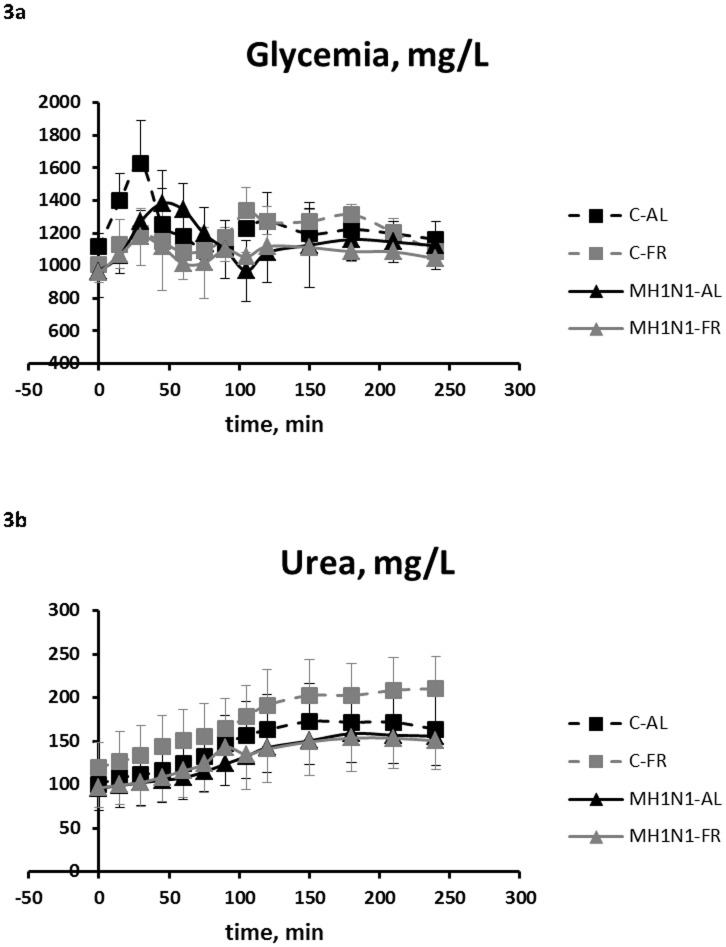
Postprandial kinetics of plasma glucose (3a) and urea (3b) concentrations (mg/L) measured in pigs.Average plasma concentrations were measured after an overnight fasting and then during the 4ïc fluid administration in co-infected (MH1N1) and control (C) pigs fed ad libitum (AL) or feed restricted (FR): C-AL (black dashed line), C-FR (gray dashed line), MH1N1-AL (black solid line) and MH1N1-FR groups (gray solid line). Values are means +/− SD. P values for glucose: PI<0.05 at fasted basal state, 15 and 30 min after the meal, then from 105 to 210 min; PFR<0.05 from 15 to 60 min after the meal. P values for urea: PI<0.01 from 60 to 240 min.